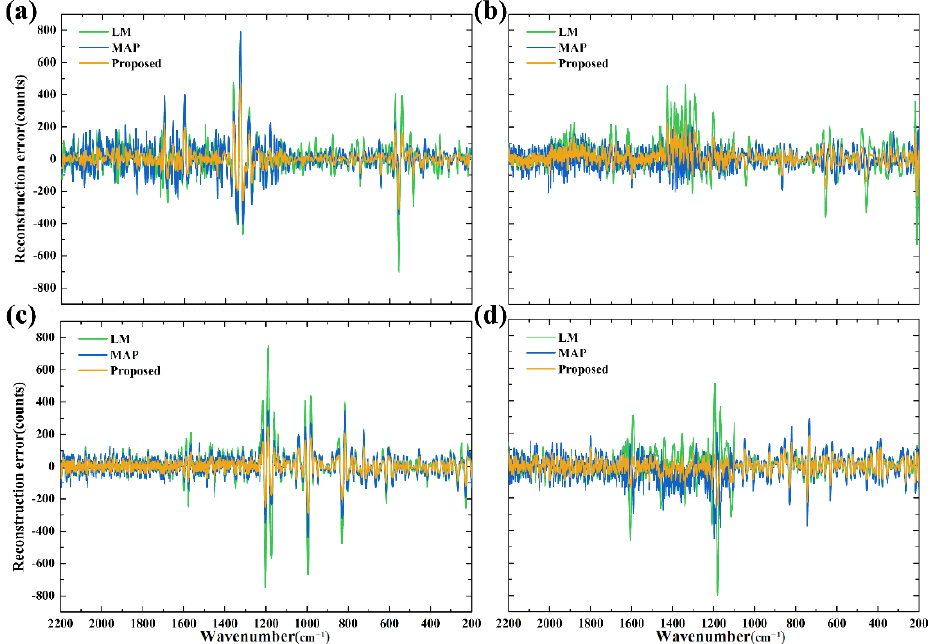
Figure 12. Reconstruction errors of Raman spectra by several methods. ( a ) Caffeine; ( b ) ketamine; ( c ) methamphetamine; ( d ) ibuprofen.